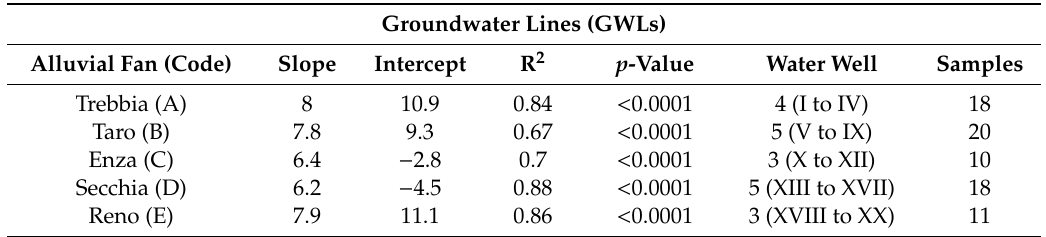
Table 5. Groundwater lines (GWLs) for the alluvial fans (apices) considered in this study. The number of water wells and samples used for interpolations (ordinary least squares regression—OLSR) are also reported along with statistical parameters (R 2 and p